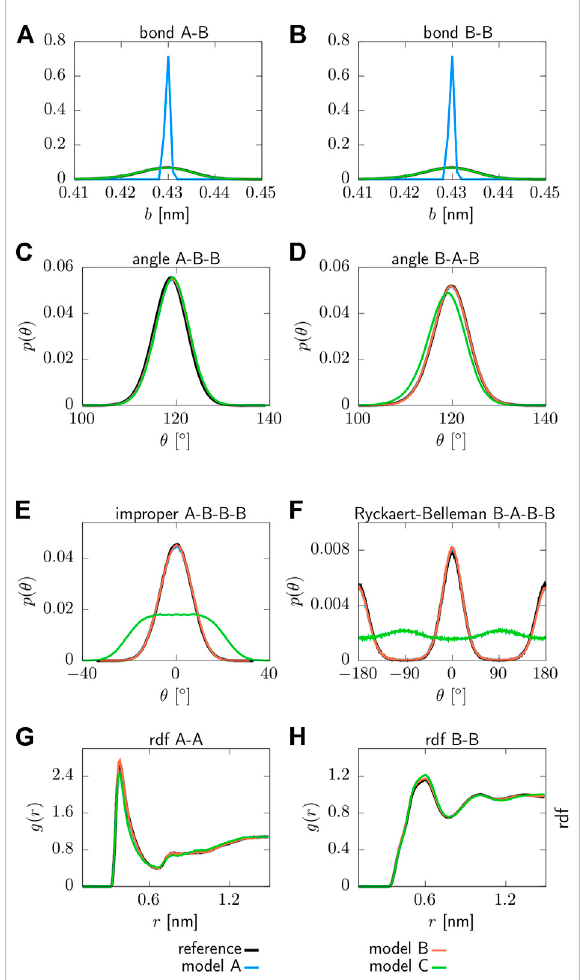
FIGURE 2 Structural distribution functions for various force fi eld